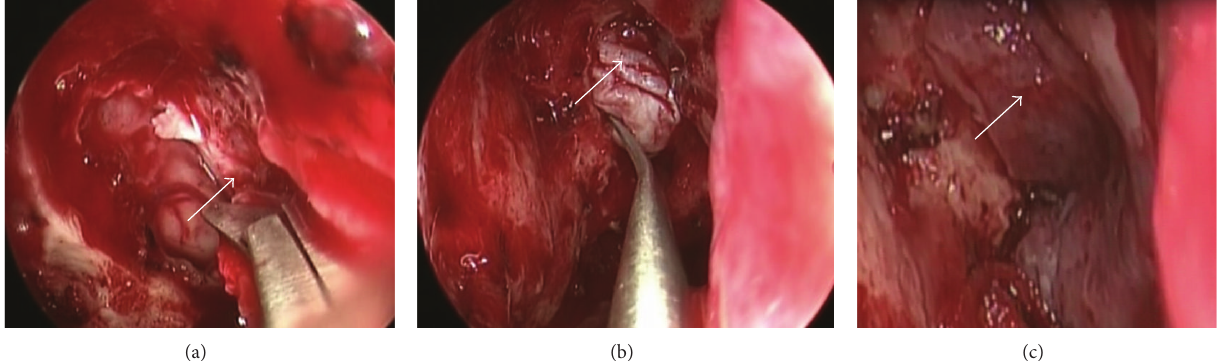
Figure 6: Intraoperative findings in case 2. Surgery was performed by dura resection ((a) white arrow) and duraplasty using fascia lata ((b) white arrow) plus a pedicled nasal septal flap ((c) white arrow).